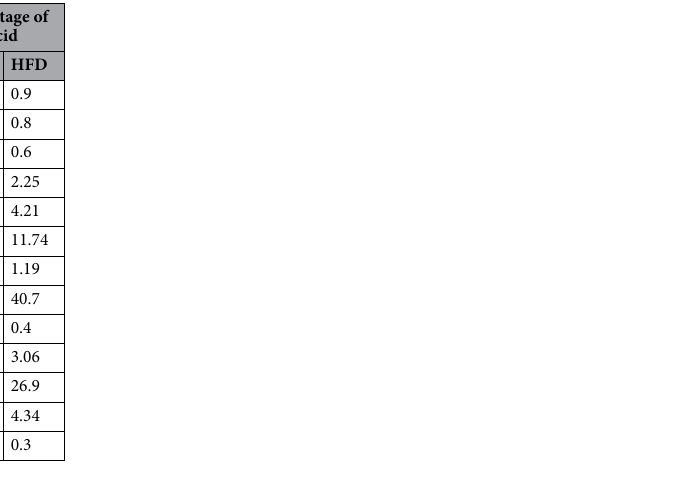
Table 3. Percentage of fatty acids in normal and high-fat